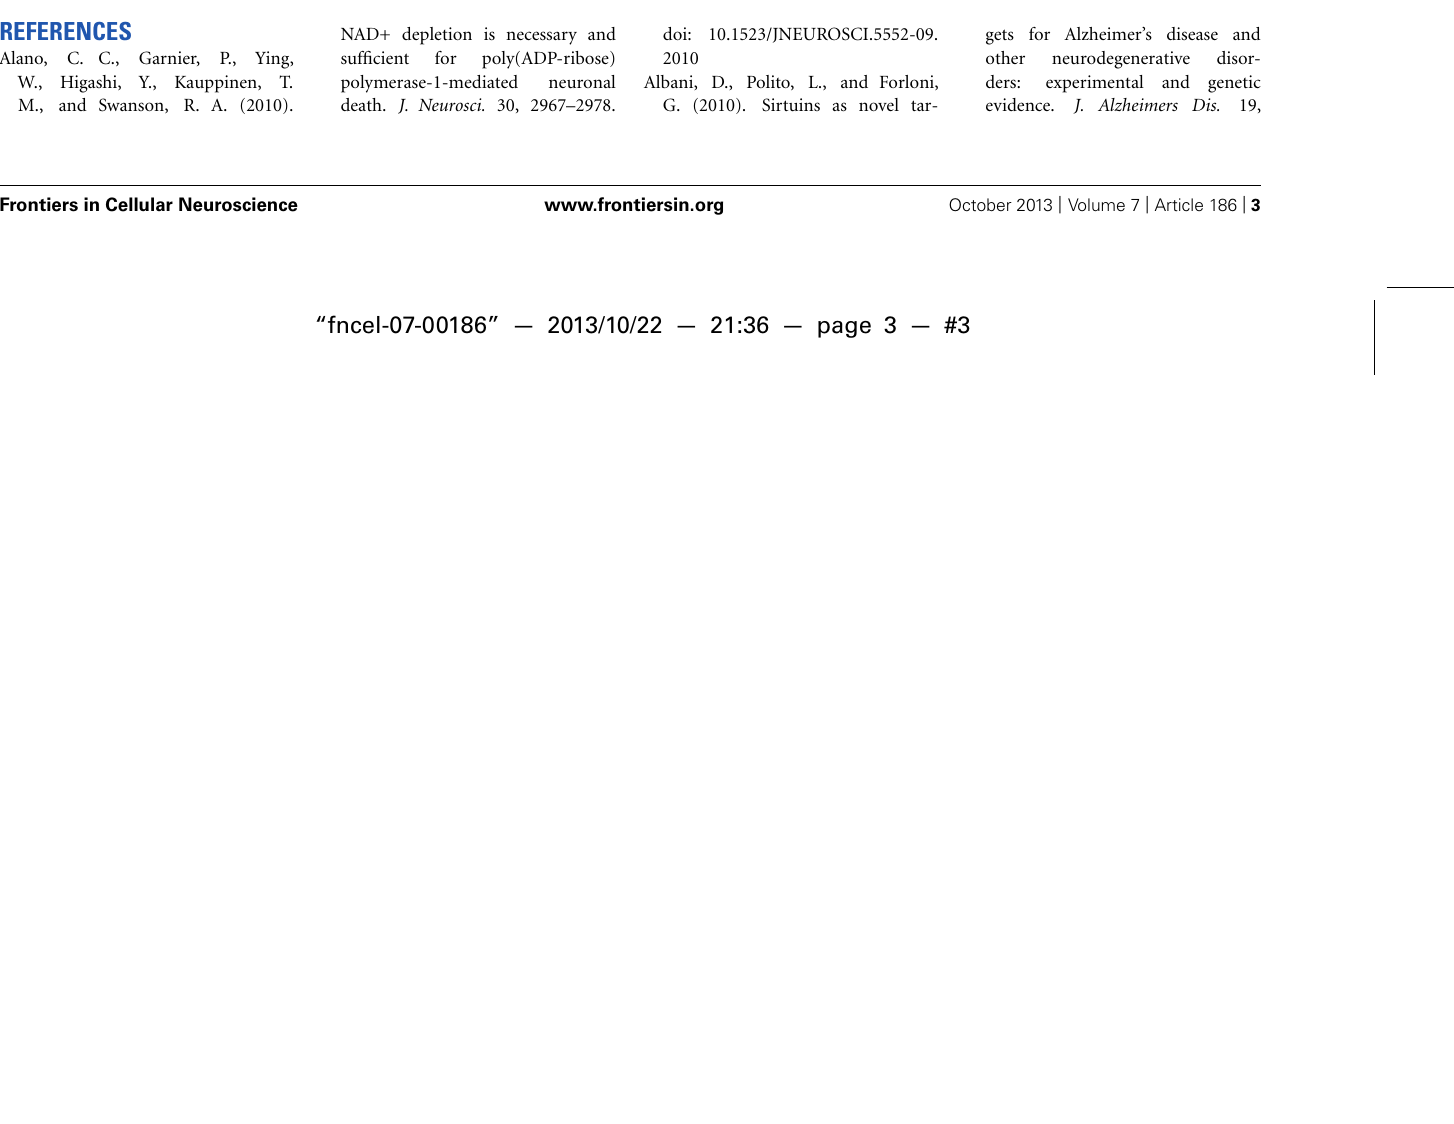
hand, Sirt1 have been shown to modulate IGF-1 signaling axis by deacetylation of IRS-2 in human embryonic kidney cells and rat cortical neurons (Li etal., 2008), as well as suppressing IGF-1 and IGF-1R expression in NG108-15 (a mouse neuroblastoma/rat glioma hybrid cell line; Sansone etal.,